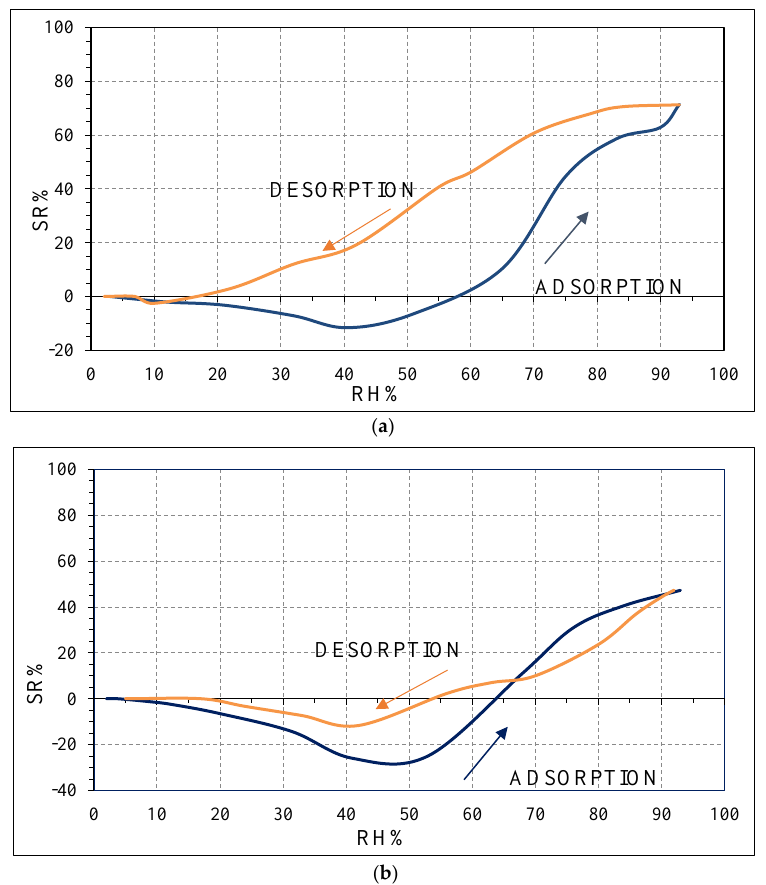
Figure 12. Sensor response toward relative humidity for SWP700 biochar with ( a ) 10%; ( b ) 20% of PVP acting as polymeric binder. Table 4. Maximum SR% of PVP, OSR700, SWP700, SWP-10% PVP, and SWP-20% PVP sensors toward relative humidity at 26 °C.